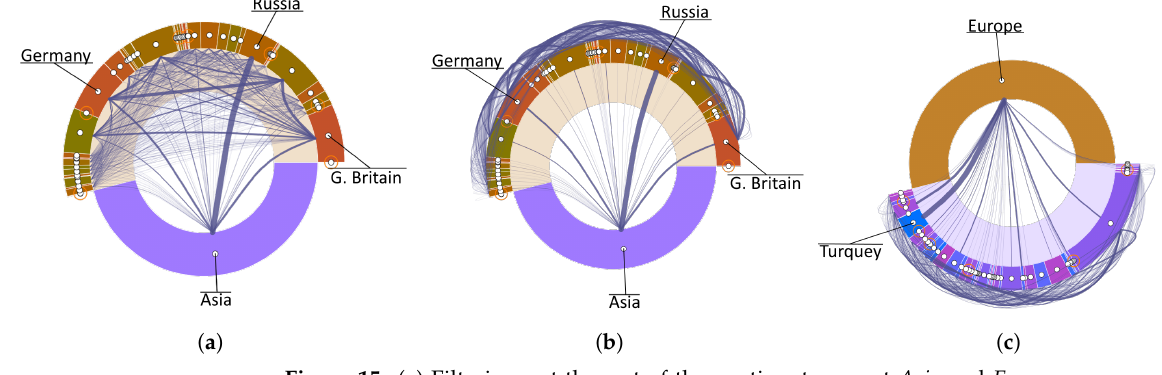
Figure 15. ( a ) Filtering out the rest of the continents except Asia and Europe , we can analyze the connectivity between them. By uncollapsing Europe , we can see that European Russia is the country with the most connections to Asia . ( b ) By painting the connections among sibling countries on the outward side of the sunburst, the external routes are more sharply observed. In this image it is easy to see that the European countries that are most connected to Asia are Russia , Great Britain , and Germany .